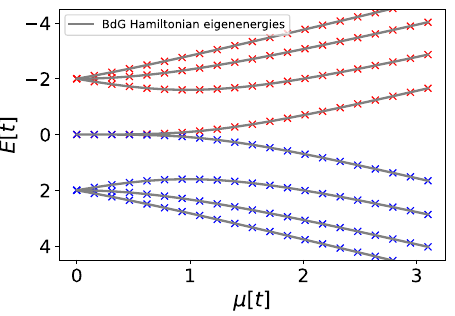
Figure 5. Quantities of a 4-site Kitaev Hamiltonian at t = − 1 and (cid:31) = 1 as a function of the chemical potential µ in units of absolute value of tunnelling [ t ]. Red denotes values obtained on an ideal simulator of quantum computers with � P (µ = 0 + ) � = 1 . Blue denotes values obtained on an ideal simulator of quantum computers with � P (µ = 0 + ) � = − 1 . The single-particle picture BdG spectrum, diagonalizatioin of the BdG Hamiltonian (grey lines) compared to Gaussian state solutions (coloured